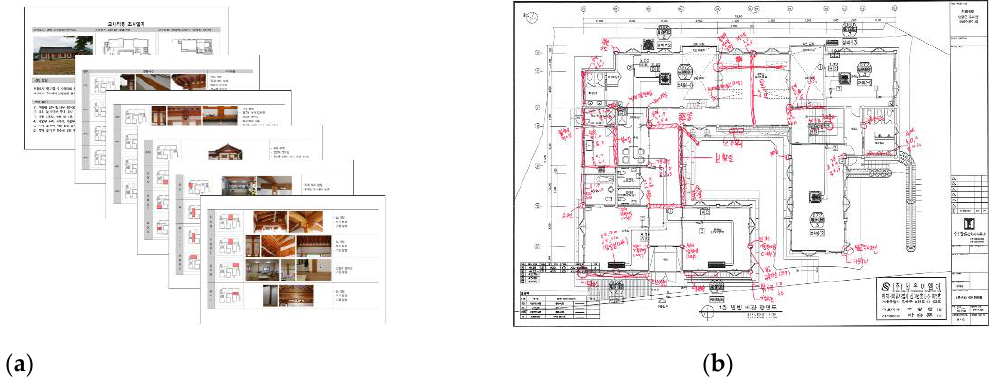
Figure 4. Monitoring method for the Hanok maintenance: maintenance checklist. ( a ) Photographic record by section; ( b ) Damage checks through architectural drawings.